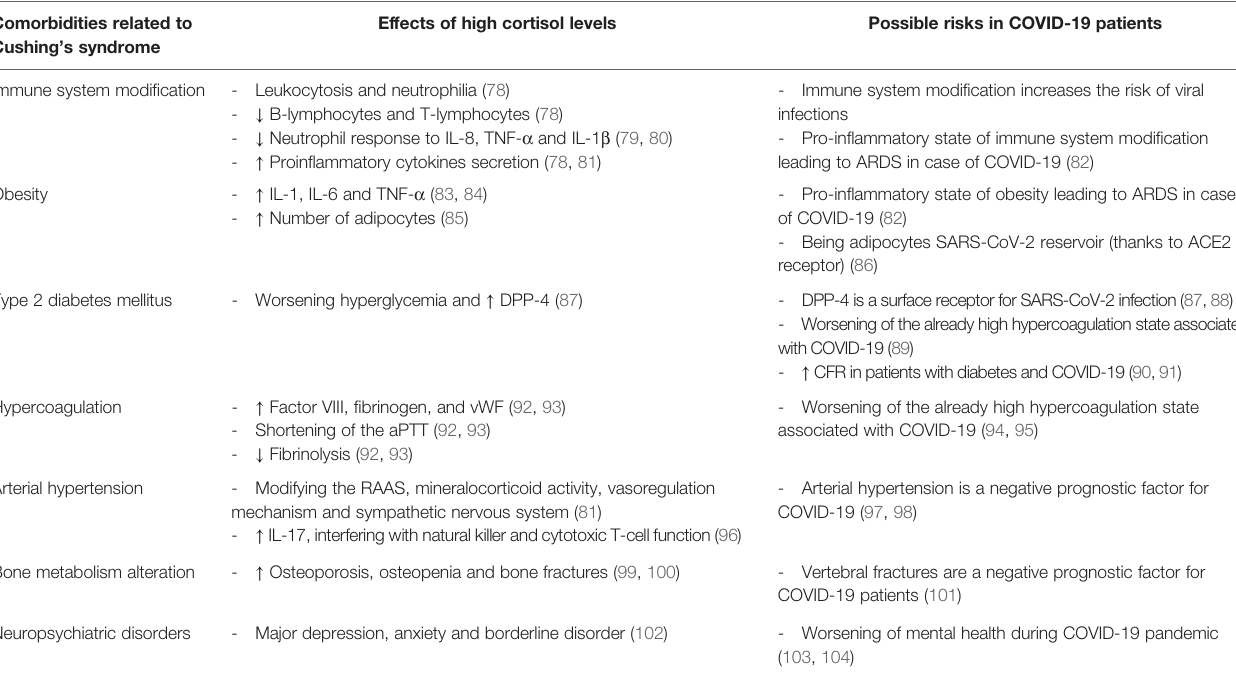
TABLE 2 | Cushing ’ s syndrome comorbidities and possible interactions with